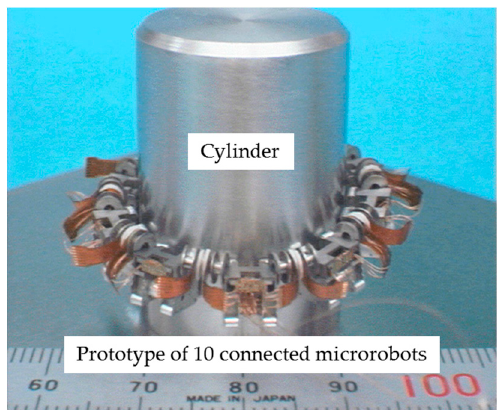
Figure 18. Prototype of 10 connected microrobots for evaluating the vertical driving performance with 10 connected microrobots. Ten microrobots were arranged around a cylinder simulating a pipe. There were three types of microrobots: a driving microrobot with driving devices, a flaw-detection microrobot with a flaw-detection sensor but no driving device, and a transmission microrobot with transmit power and sensor signals but no driving device.